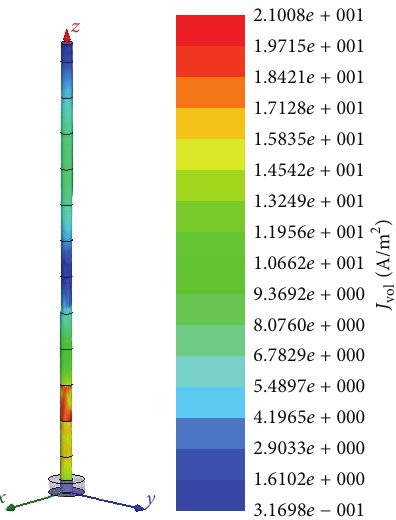
Figure 6: Electrical current distribution along the plasma antenna from HFSS